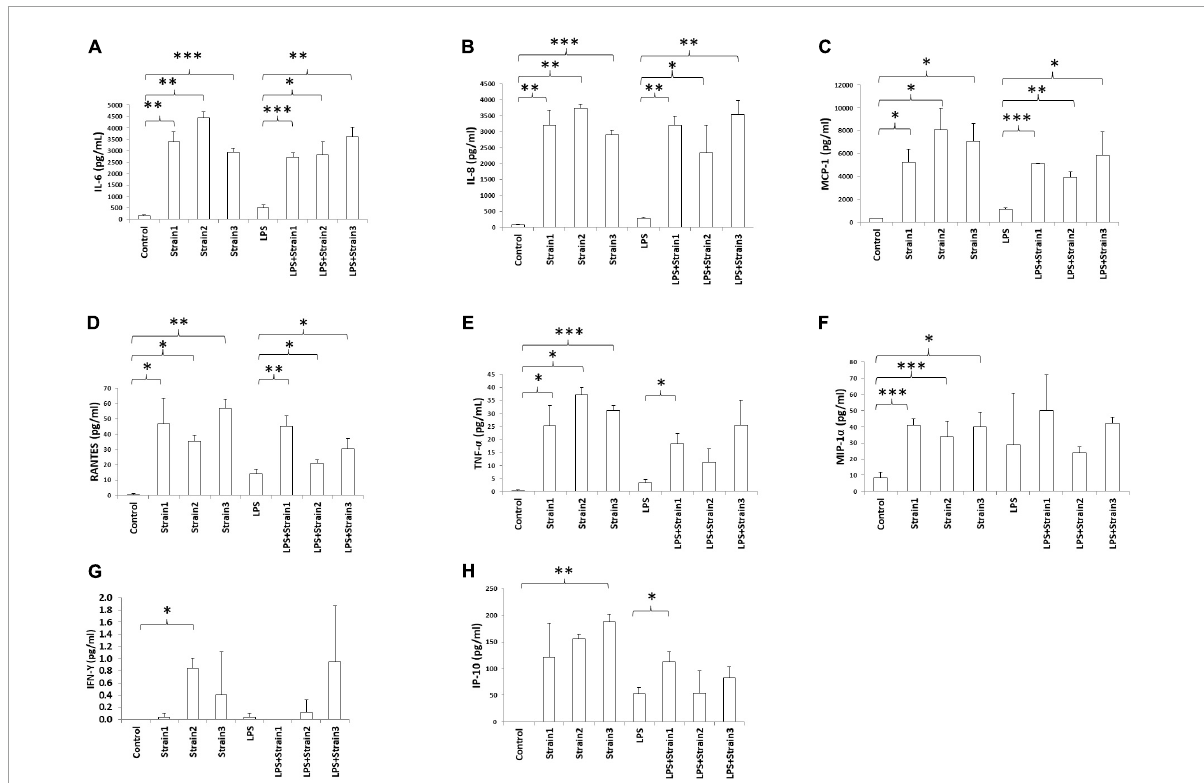
FIGURE6 Achromobacter induced cytokine production in human corneal epithelial cells (serum free culture supernatant). (A) IL-6; (B) IL-8; (C) MCP-1; (D) RANTES; (E) TNF- α ; (F) MIP-1 α ; (G) IFN- γ ; (H) IP-10. IL, interleukin; TNF- α , tumor necrosis factor alpha; MIP, macrophage inhibitory protein; MCP, monocyte chemotactic protein; IFN, interferon; IP, interferon gamma-induced protein; RANTES, regulated on activation normal T cell expressed and secreted. The height of bars indicates the mean of three biological replicates. The error bars indicate one standard deviation ∗ p < 0.05, ∗∗ p < 0.01, ∗∗∗ p <